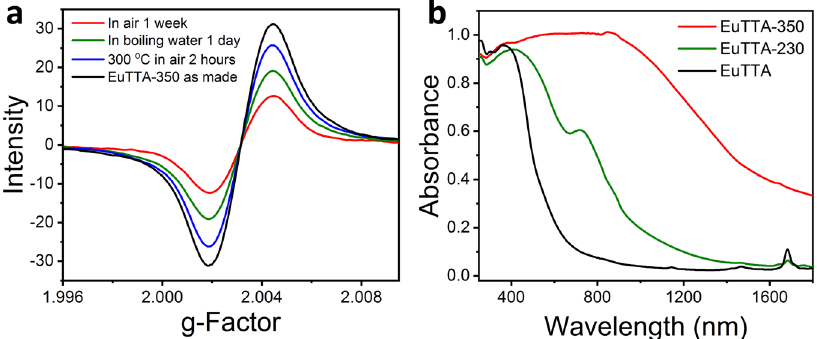
Fig. 4 | Characterization of the stability and light absorption of EuTTA-350. a The solid-state electron paramagnetic resonance (EPR) spectrum of EuTTA-350